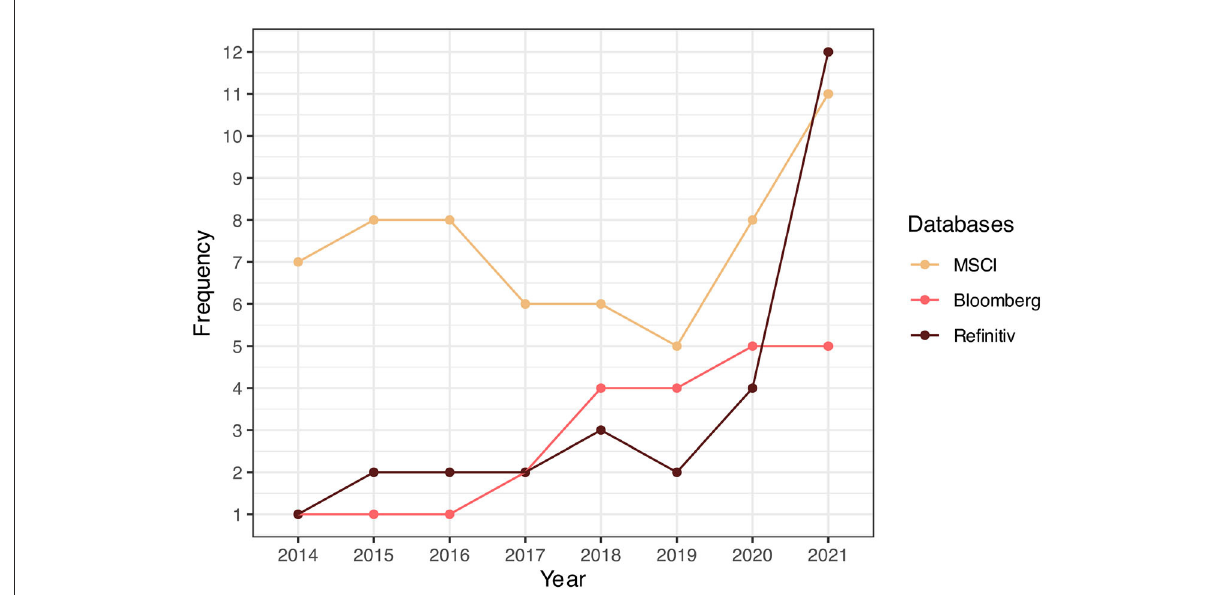
FIGURE4 The frequency of using ESG metrics in reviewed papers. This figure shows the frequency of using ESG databases from 2014 to 2021. There are several studies using multiple